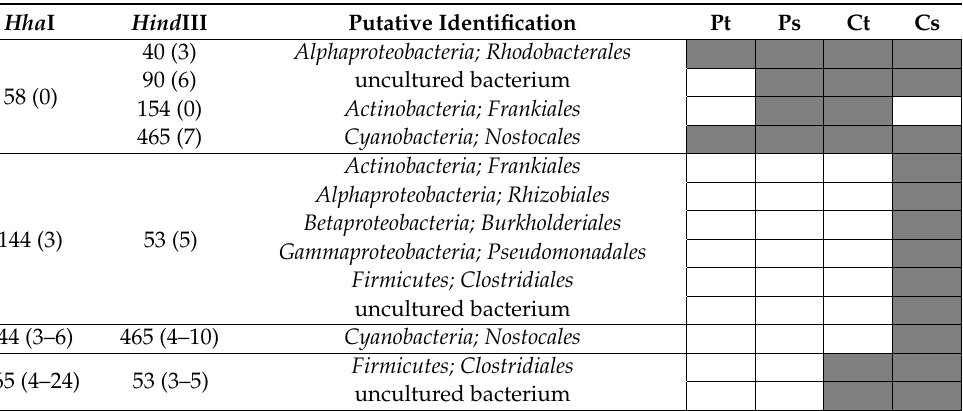
Table 1. Tentative identification of the nif H terminal restriction fragments (TRFs) by an in silico analysis of the profiles obtained from thalli and substrates of Peltigera and Cladonia lichens.